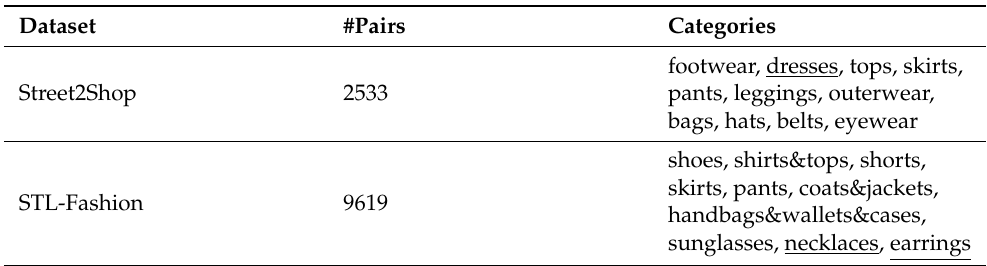
Table 2. Data statistics after pre-processing. The underlined category is handled separately or not used by our